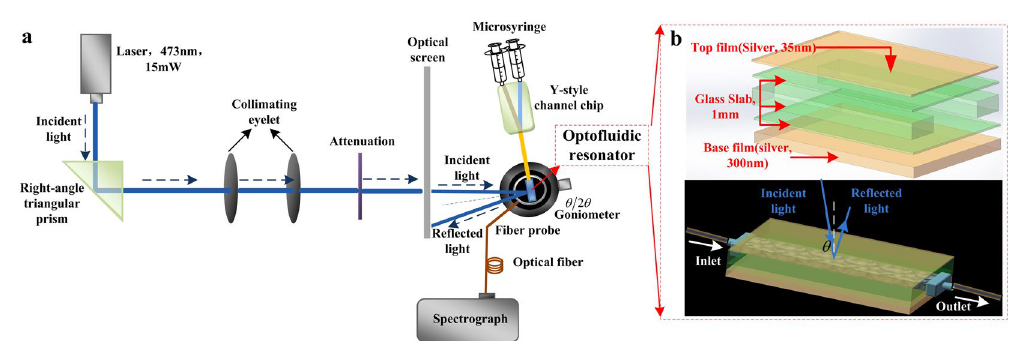
Figure 2. Y-style fluidic channel and molecules structure of metheme and heme. ( a ) The Y-style fluidic passageway (drawn by Solid Works 2012 soft ware); ( b ) The reaction process of Protoporphyrin IX with Fe 2 + and Fe 3 + , respectively (drawn by Chem 3D software).